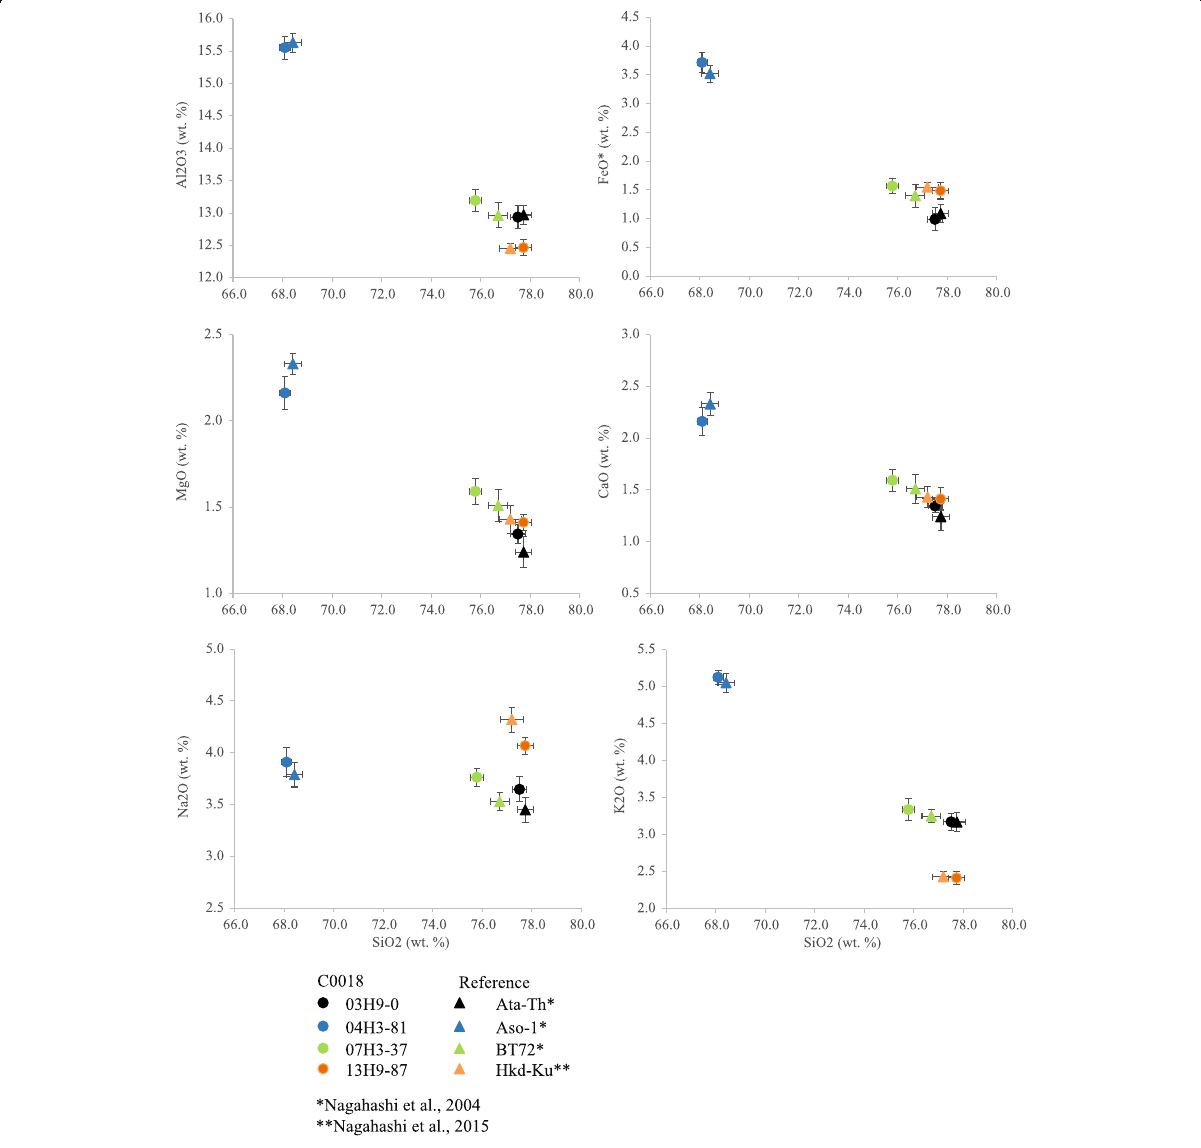
Fig. 6 Major oxide compositions of on-land reference tephras and tephras in C0018. The data of the on-land tephras (Table 3; Hayashida et al. 1996; Kuwae et al. 2002; Nagahashi et al. 2004, 2015; Suzuki et al. 2005; Yoshikawa and Mitamura 1999) are marked by triangles , and data of the C0018-tephras are marked by circles . Matching tephras are highlighted by the same color. Error bars represent one standard